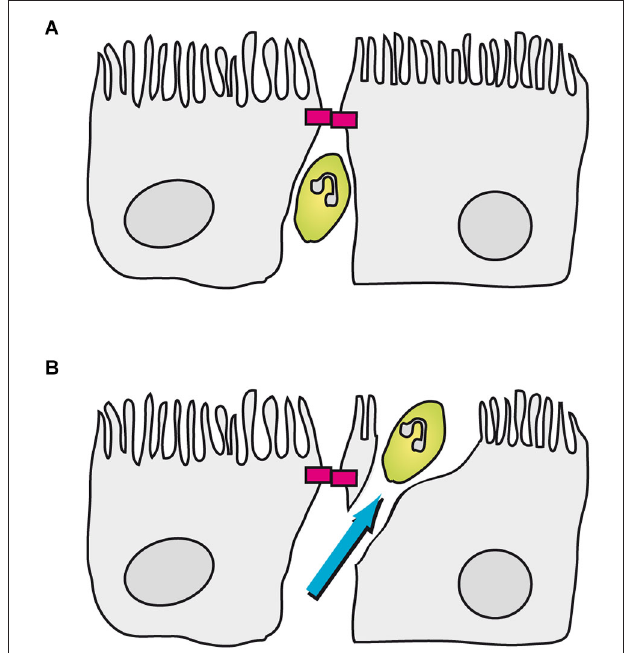
FIGURE 3 | Transmigration of porcine PMNs in an in vitro model of the BCSFB based on PCPEC . In this model PMNs can be found between CP epithelial cells up to the apically located TJs (magenta blocks). (A) Once a PMN encounters a closed TJ, the neutrophil stops in front of the TJ. (B) Subsequently, the PMN finishes transmigration in a transcellular fashion, which involves the formation of a “funnel-like” structure originating from the apical membrane of the